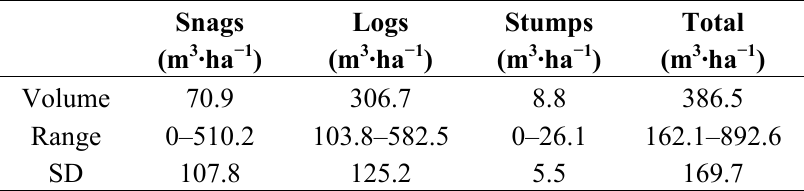
Table 2. Volume of coarse woody debris types in the core area.